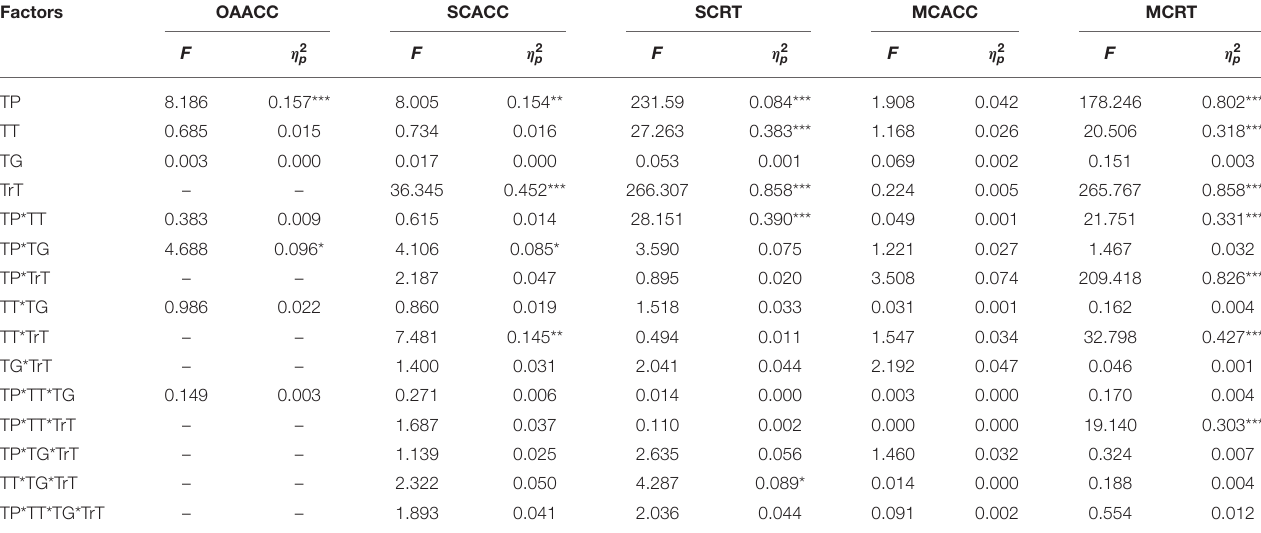
TABLE 4 | Significance statistics of mixing trials. Factors